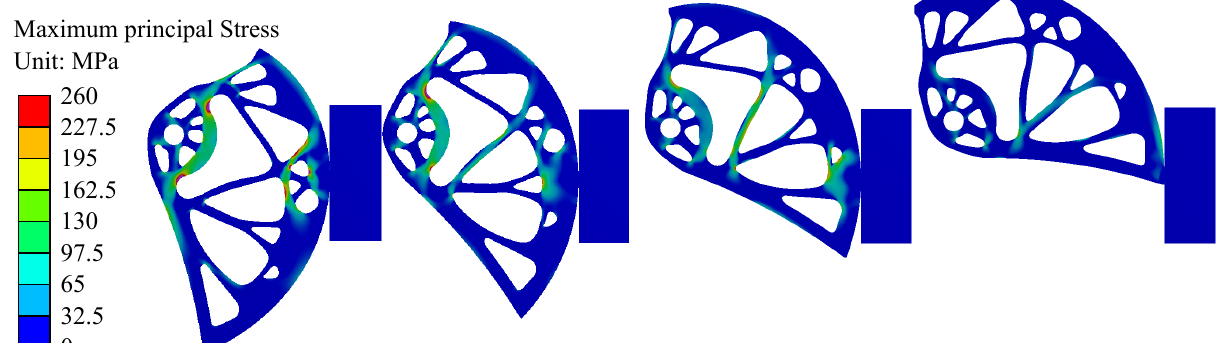
Figure 13. Maximum principal stress fields corresponding to the force F min = 5.00 kN ( F = 1.25 kN) for different widths of the rock crack w = 75, 86, 97, 108 mm (from left).